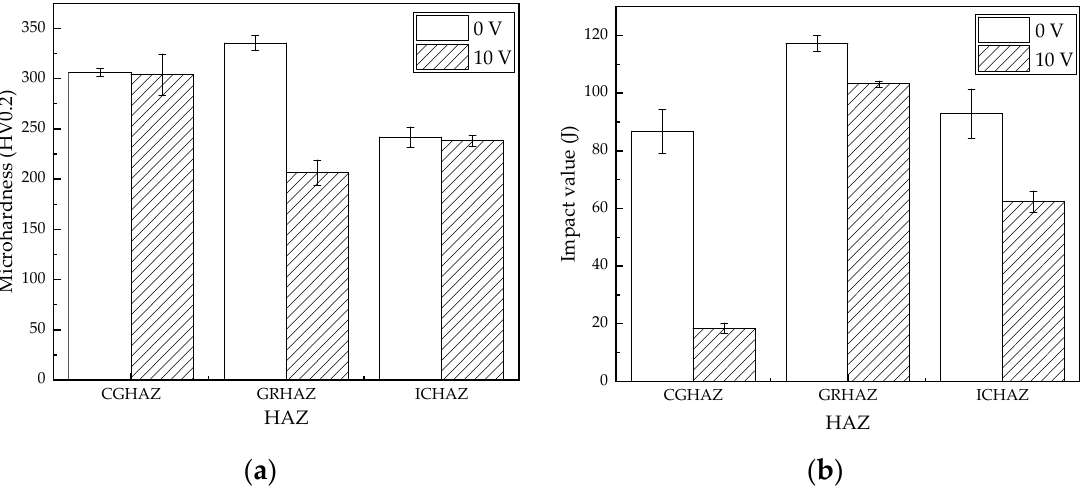
Figure 8. Comparison of the properties of the welding thermal simulation samples: ( a ) microhardness; ( b ) impact value at − 20 °C.